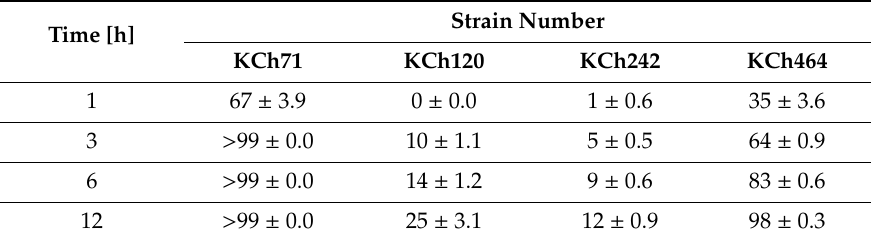
Table 3. Transformation of the substrate 3 by selected